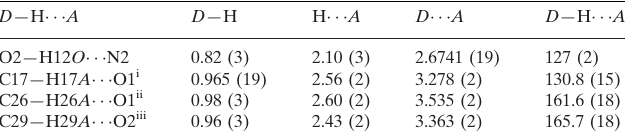
Hydrogen-bond geometry (A˚ , (cid:2) ). D —H (cid:3)(cid:3)(cid:3)